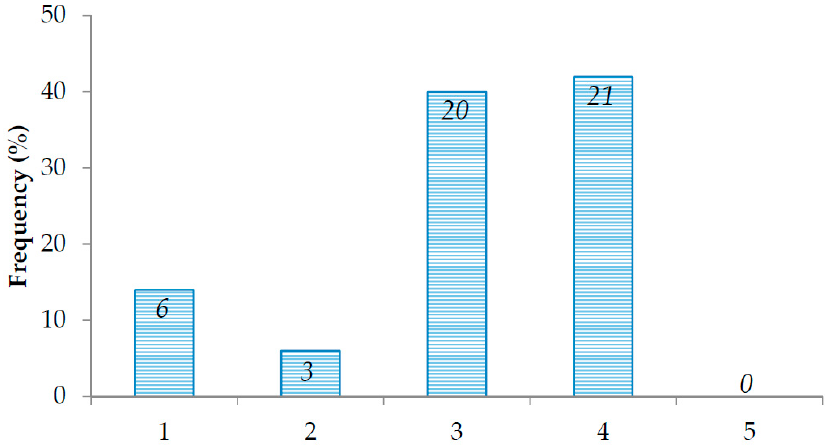
Figure 3. Proportion of projects achieving ecological restoration milestones (n = 50; italicised numerals within bars indicate the number of groups at each status).